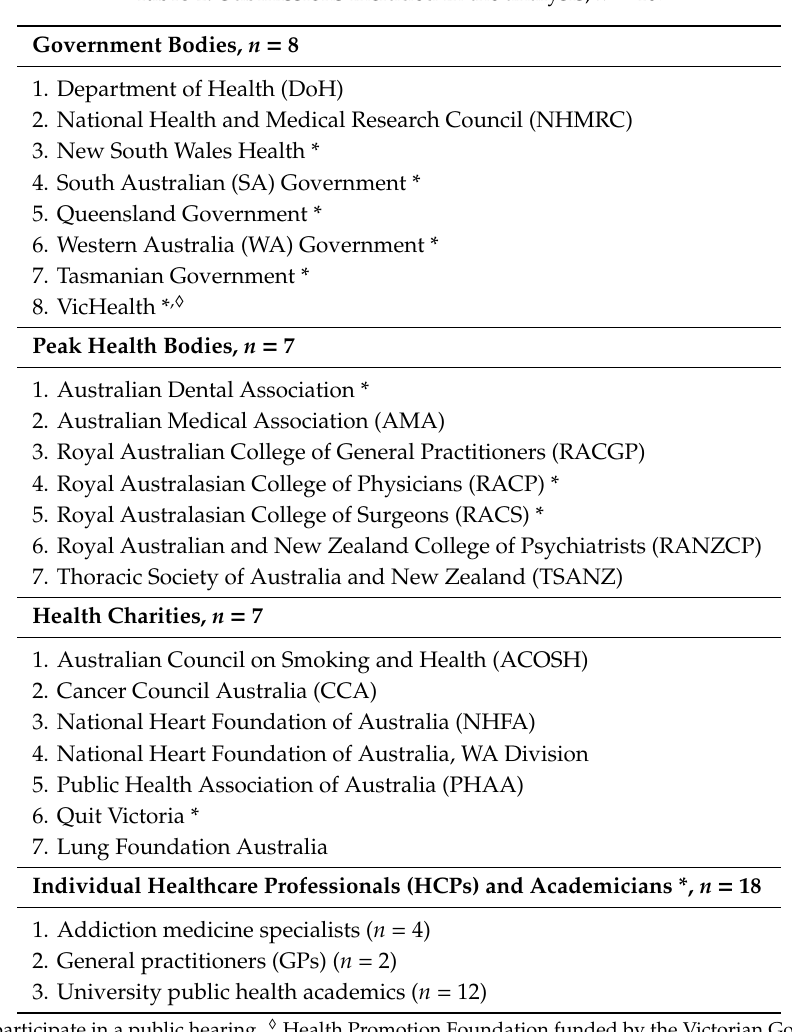
Table 1. Submissions included in the analysis, n =